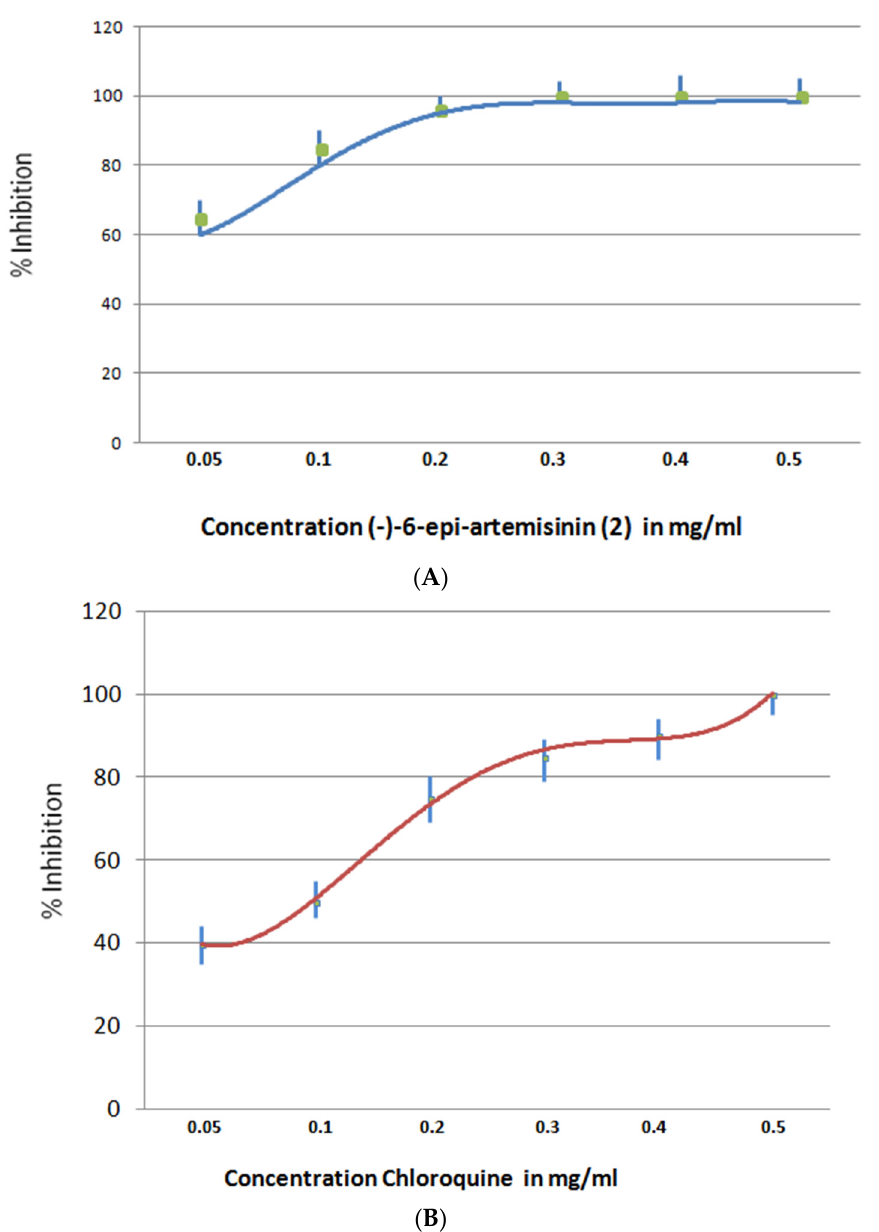
Figure 10. Inhibition of haem polymerization formation by ( A ) ( − )-6-epi-artemisinin ( 2 ) (blue) with IC 50 = 3.5 ± 0.002 nM and ( B ) chloroquine (red) with IC 50 = 18 ± 0001